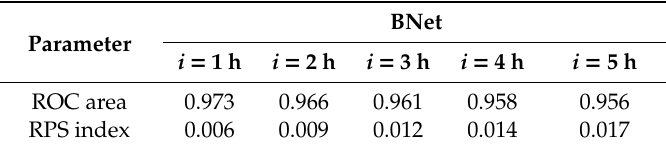
Table 4. Values of the parameter that quantify the forecast quality of the BNet, in a time step from 1 to 5 h.